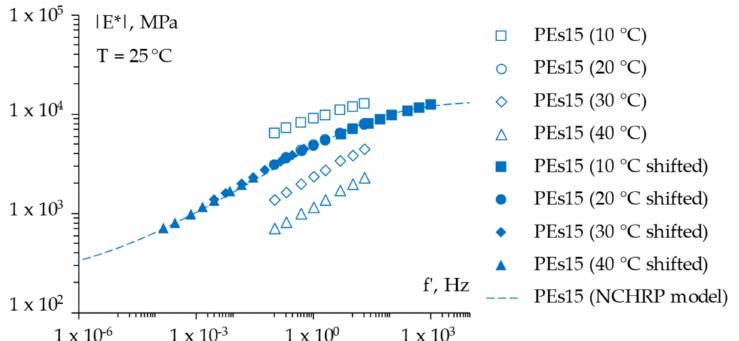
Figure 10. The frequency sweep results (master curve) of the PEs15 mixture.